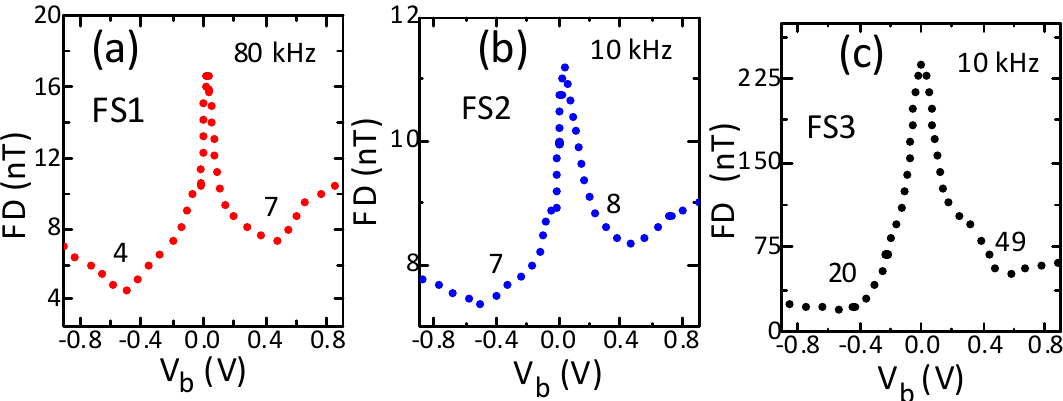
Figure 6. Influence of bias voltage on high-frequency field detection of sensors with high ( a ), medium ( b ) and low ( c ) sensitivity. The field detection was measured at the highest sensitivity point on the transfer curve. The field detection showed significant improvement with bias and all sensors showed the best field detection under negative polarity.